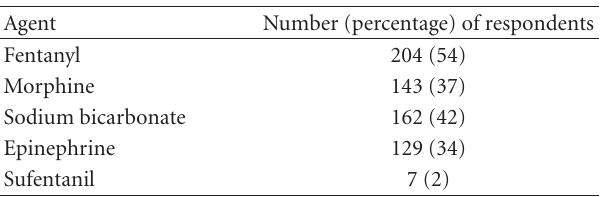
Table 1: Agents added to epidural local anesthetic solution for urgent cesarean